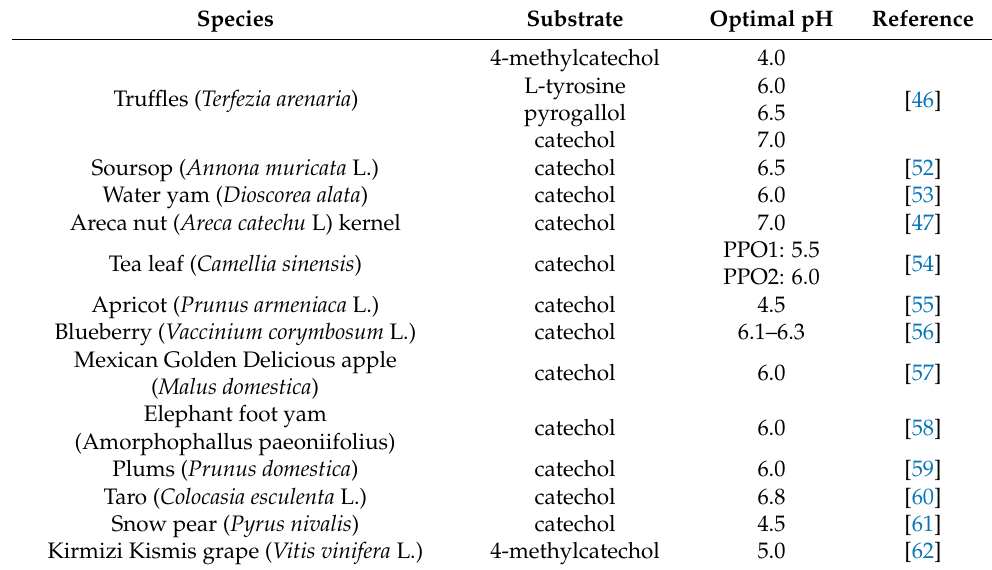
Table 1. Cont. Species Substrate Optimal